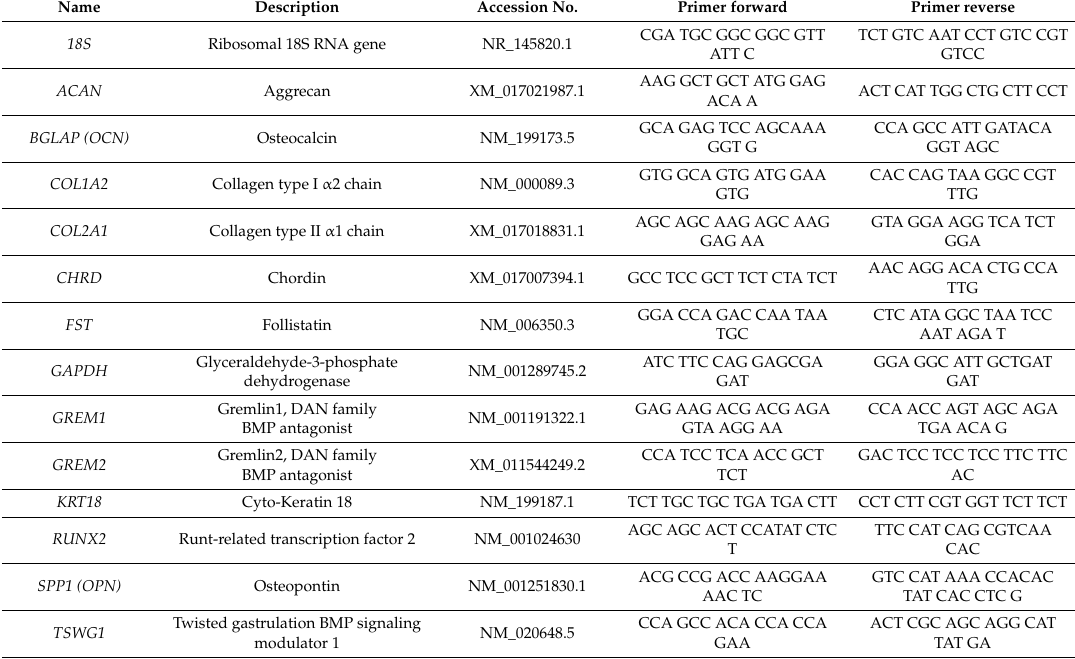
Table 2. List of genes tested during qPCR of human primary osteoblasts and human primary intervertebral disc